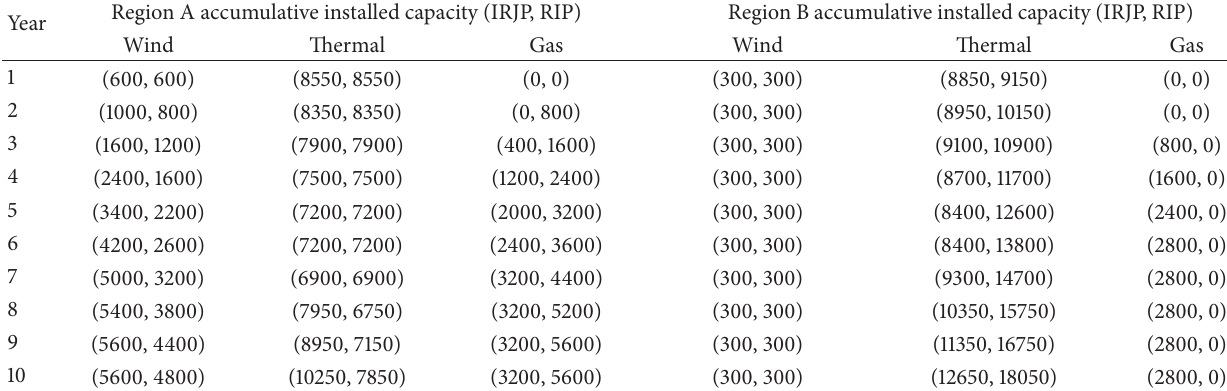
Table 9: The optimization results of system power planning in IRJP mode and RIP mode.